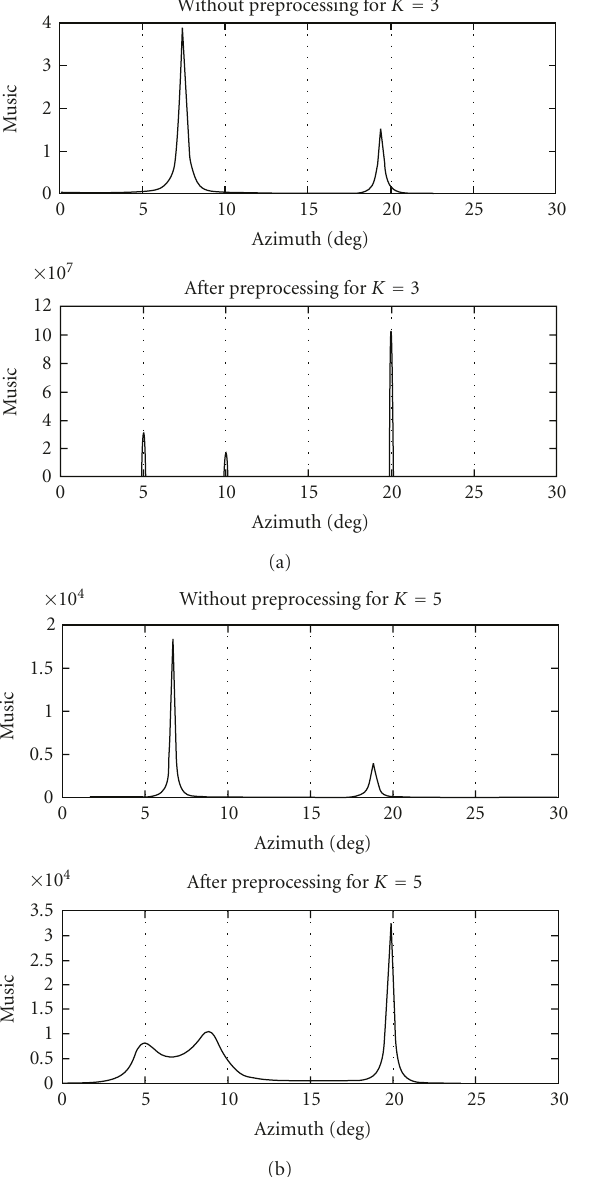
Figure 9: Localization of the three sources at 5 ◦ , 10 ◦ , and 20 ◦ without and with noise preprocessing for K = 3 and K = 5.